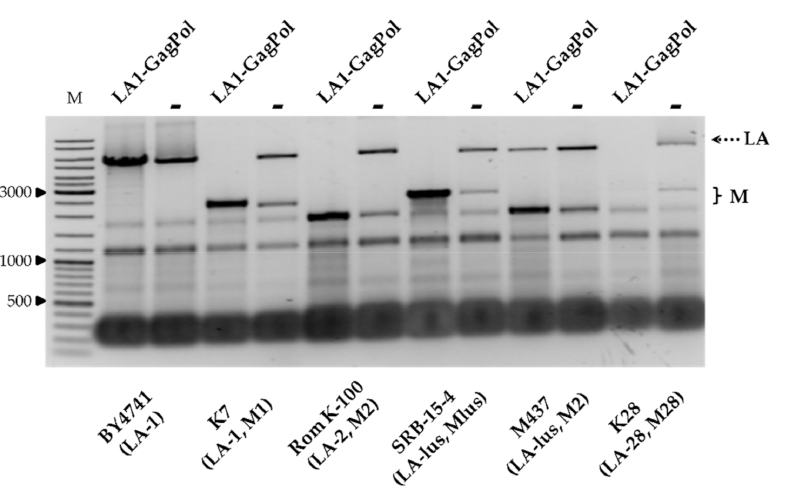
Figure 4. The impact of overexpression of LA-1 capsid proteins on the maintenance of LA and M dsRNAs in BY4741, K7, Rom K-100, SRB-15-4, M437 and K28 strains. Agarose gel electrophoresis of dsRNA isolated from respective yeast strain transformants; LA1-GagPol refers to samples trans- formed with LA-1 proteins expression vector, − denotes control samples. M column is molecular size marker (GeneRuler DNA Ladder Mix, Thermo Scientific, Vilnius, Lithuania); yeast strains with corresponding genotypes are indicated below the